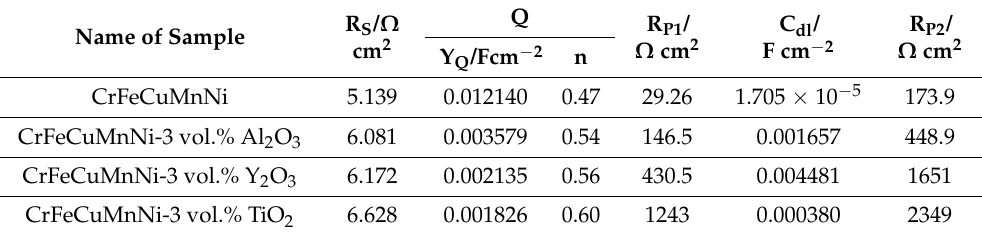
Figure 12. The equivalent circuit model used to fit the EIS experimental data. Figure 12 . The equivalent circuit model used to fit the EIS experimental data . Table 4. Impedance data obtained for the tested titanium alloys in the 3.5% NaCl Table 4 . Impedance data obtained for the tested titanium alloys in the 3.5% NaCl solution.